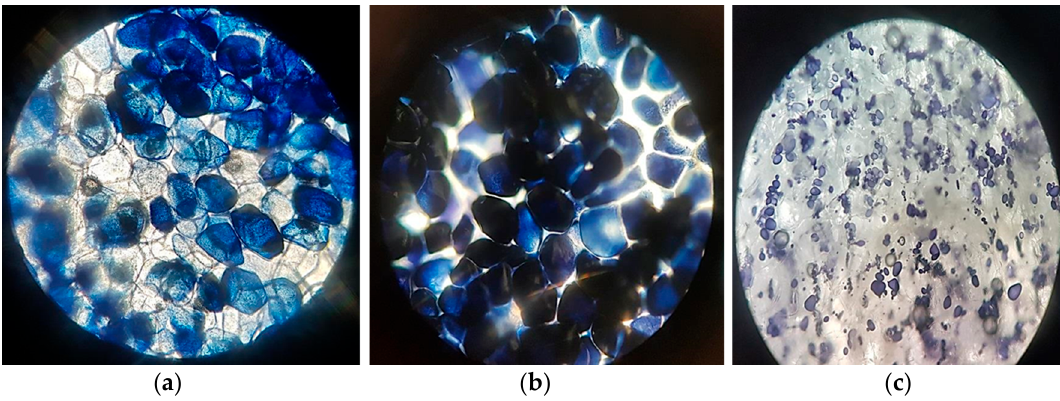
Figure 1. Microscopic images (10×) of ( a ) boiled potato, ( b ) microwaved potato, and ( c ) raw potato stained with Lugol’s iodine solution.